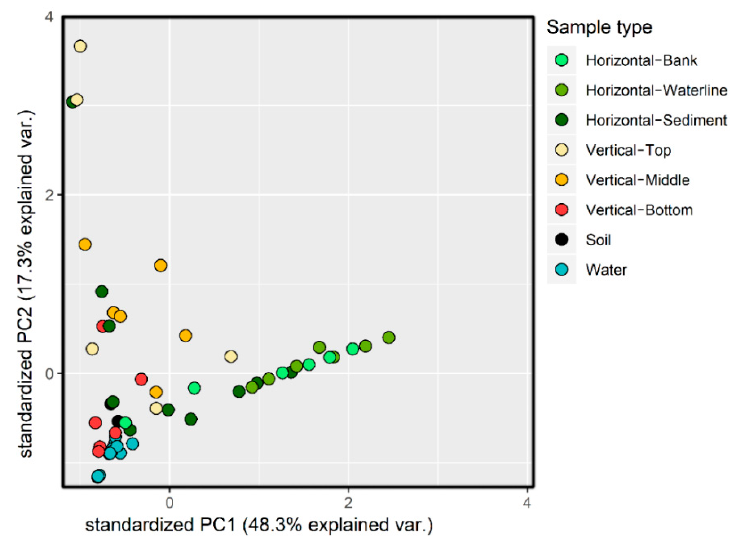
Figure 5. PCA plot of genus-level 16S rRNA gene abundance data for all Calumet area samples. Principle components 1 and 2 shown, which together explain 65.6% of variance.